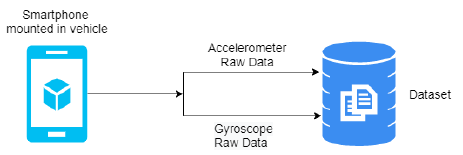
Table 1. Analysis of Literature Survey